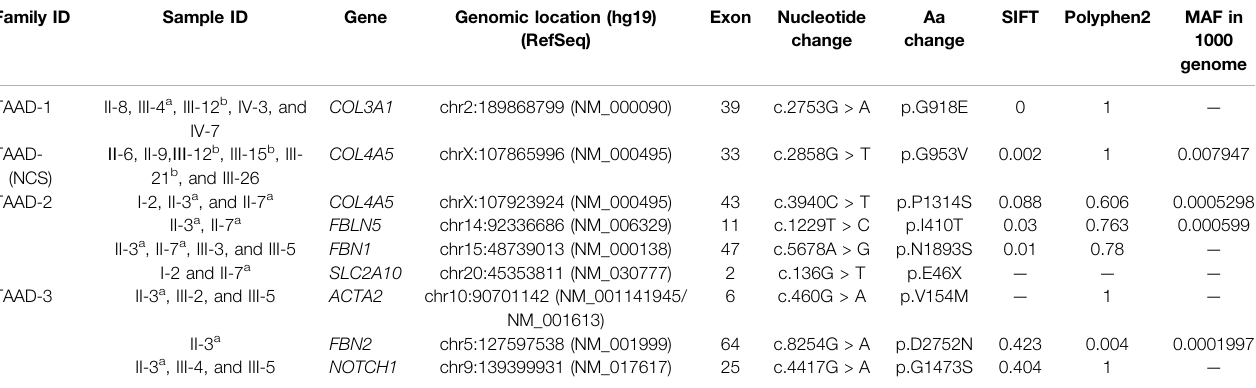
TABLE 1 | Summary of nine candidate variants in 160 known